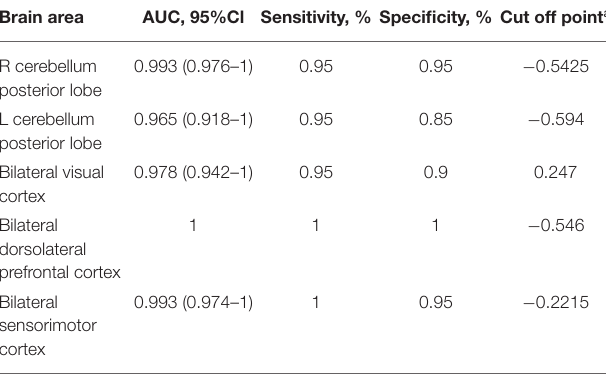
TABLE 2 | ROC curve for PerAF differences in brain areas between SD status and normal sleep